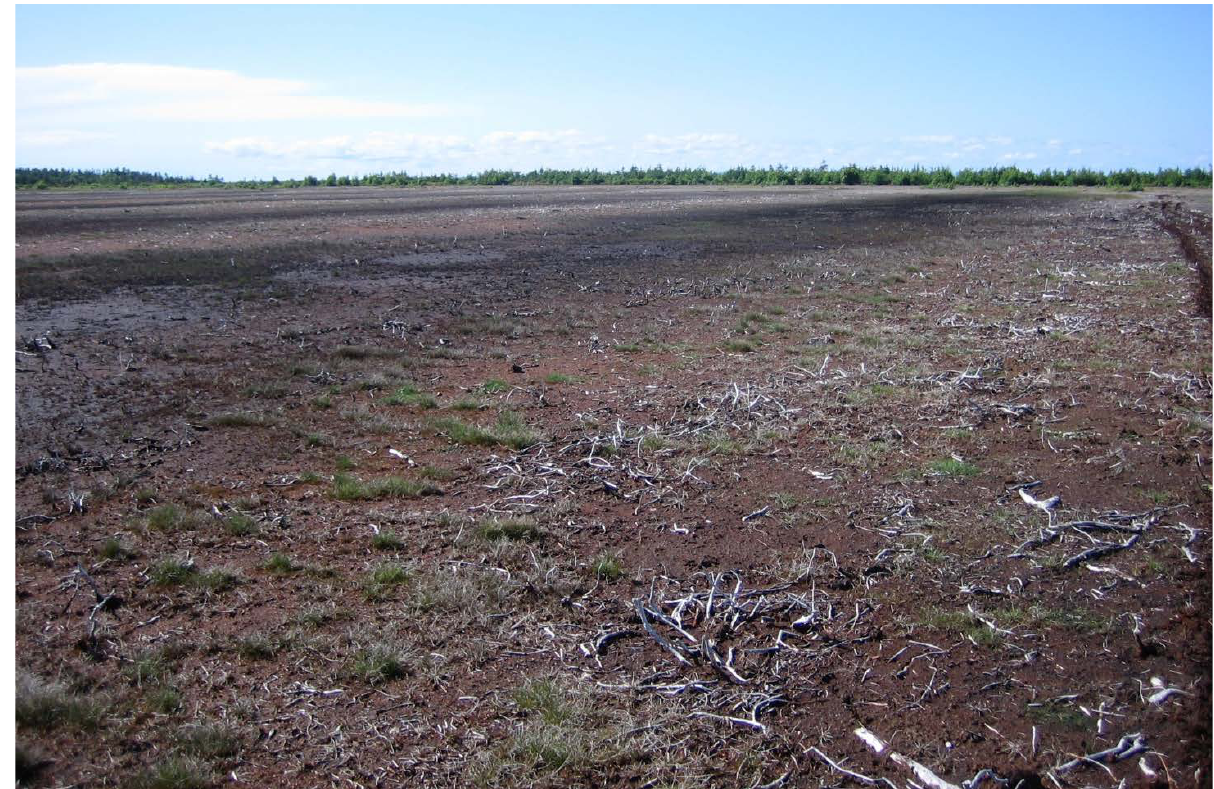
Figure A1. Bare peat in a sector of Pokesudie cutover bog in June 2011, eleven years after salt contamination.